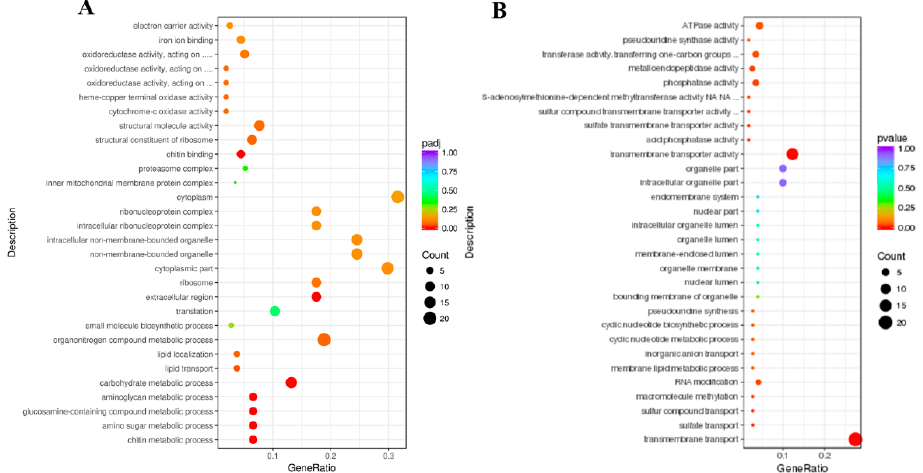
Figure 3. Gene Ontology (GO) enrichment analysis of DEGs. A scatter diagram of GO categories. The X -axis indicates the gene ratio. The Y -axis indicates different categories. ( A ) Upregulated DEGs. ( B ) Downregulated DEGs.